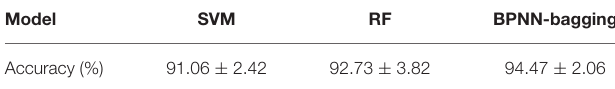
TABLE 3 | Clinical characteristics of GAD and